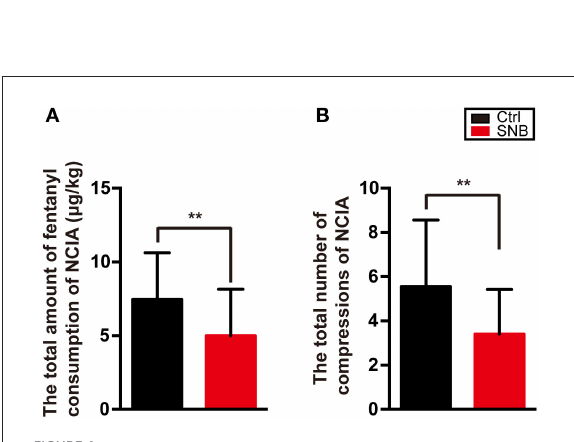
FIGURE4 The total amount of fentanyl consumption (A) and the total number of compressions (B) of NCIA in group Ctrl and in group SNB within postoperative 48h. Data are presented as mean ± SD. ** P < 0.01. NCIA, nurse-controlled intravenous analgesia; group Ctrl, control group; group SNB, scalp nerve block